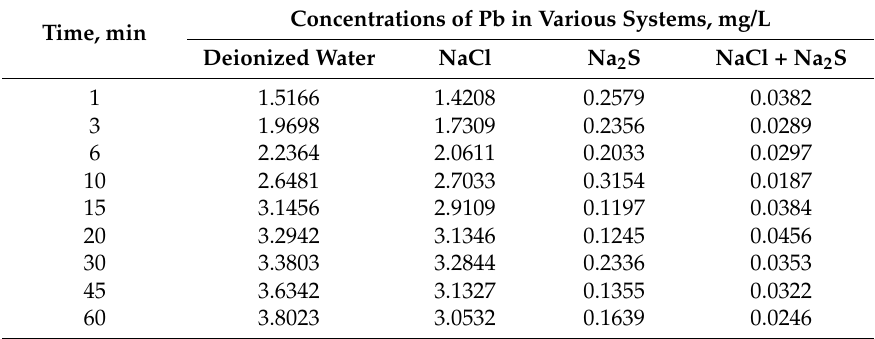
Table 1. Dissolved lead ion concentrations of cerussite in various systems as a function of time. Concentrations of Pb in Various Systems, mg/L Time, min Deionized Water NaCl Na 2